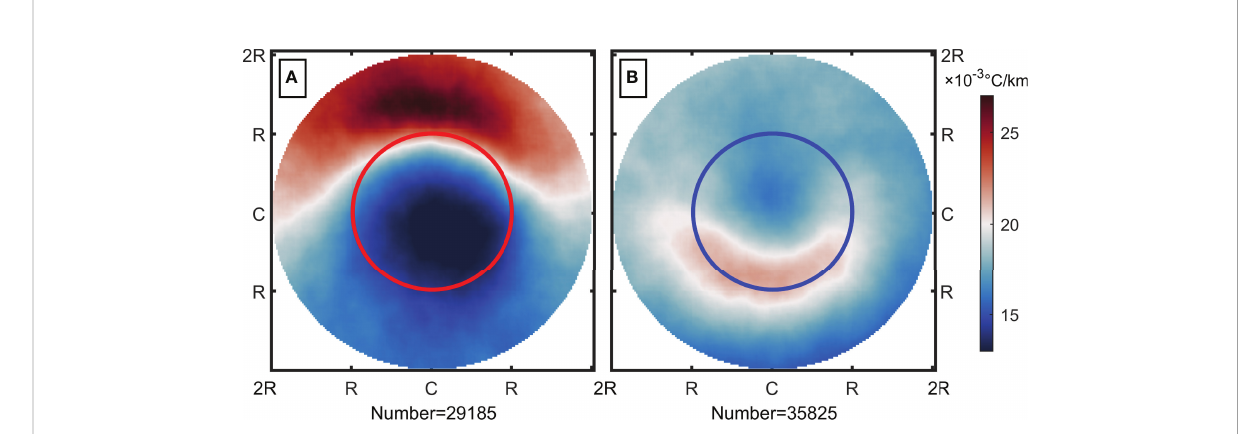
FIGURE 2 Composite of the SST gradient (×10 -3 °C/km) for (A) an anticyclone and (B) a cyclone within twice the eddy radius. The red (blue) circle represents the radius of the anticyclonic (cyclone) eddy, and the total number of composite eddies is shown in each